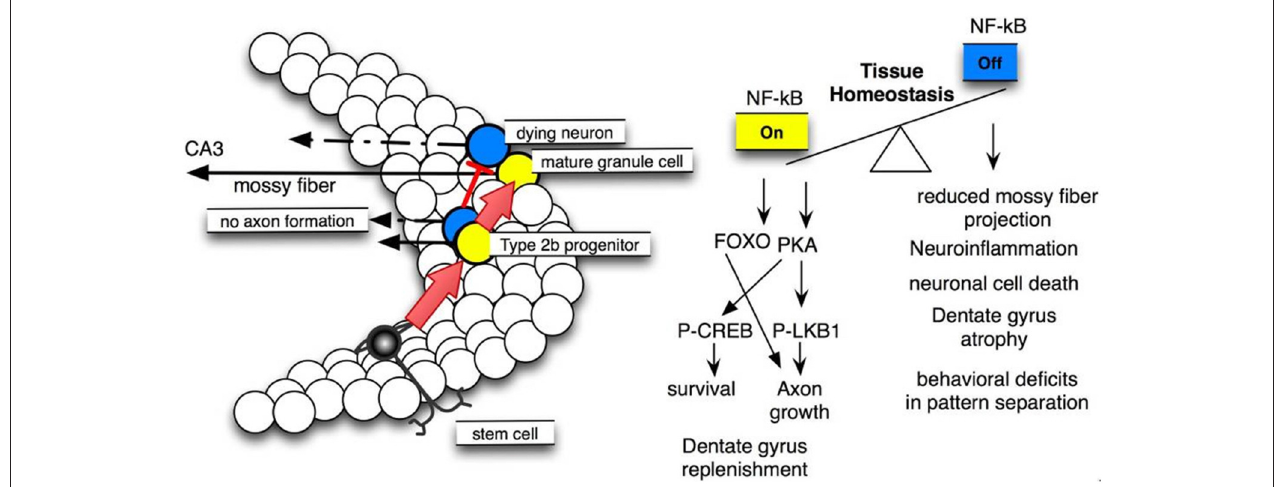
FIGURE 6 | NF- κ B signaling is crucial for dentate gyrus tissue homeostasis. Left site: scheme of neural stem cell differentiation in the dentate gyrus, note that NF- κ B activation is essential for type 2b progenitor (yellow) maturation to mature granule cells. Right site: molecular pathways involved and resulting phenotypes.